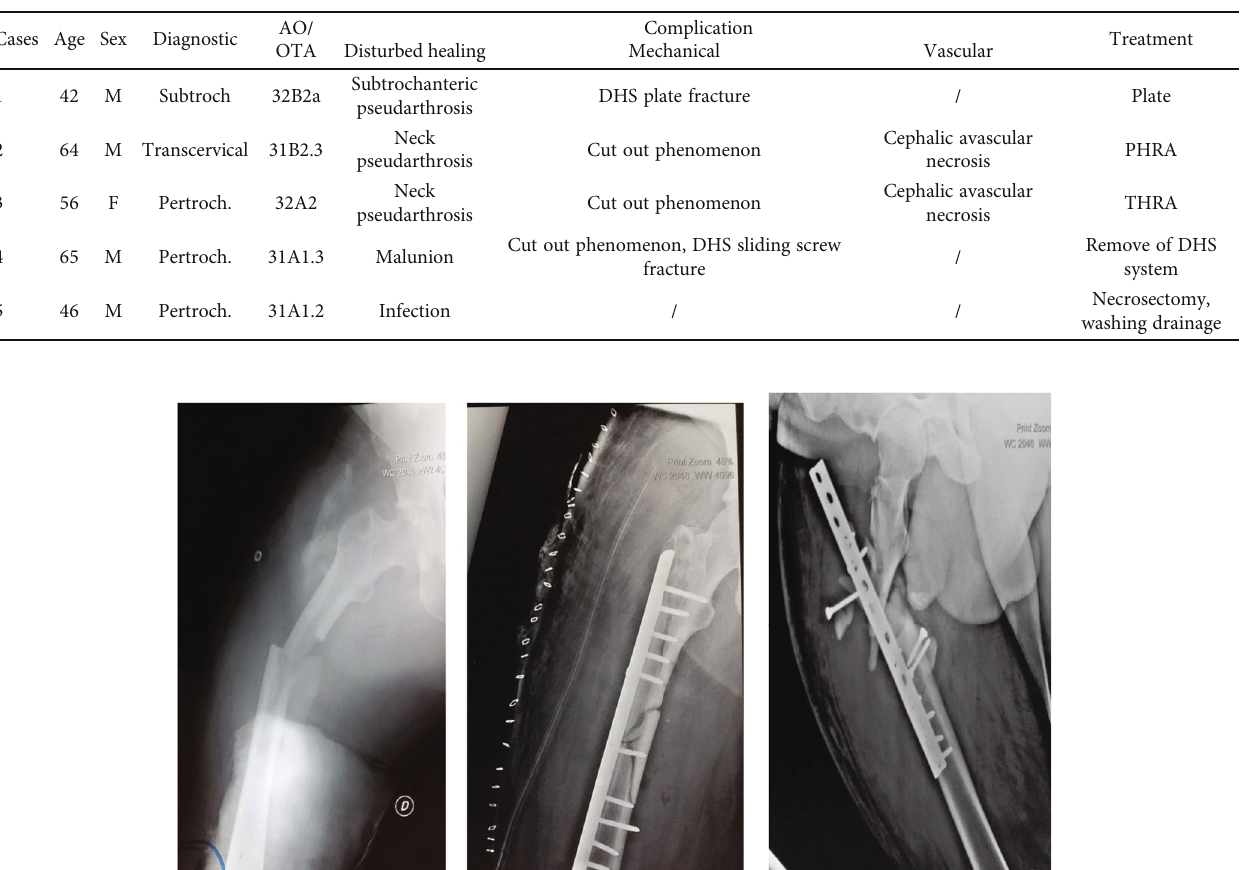
Table 1: Case series.